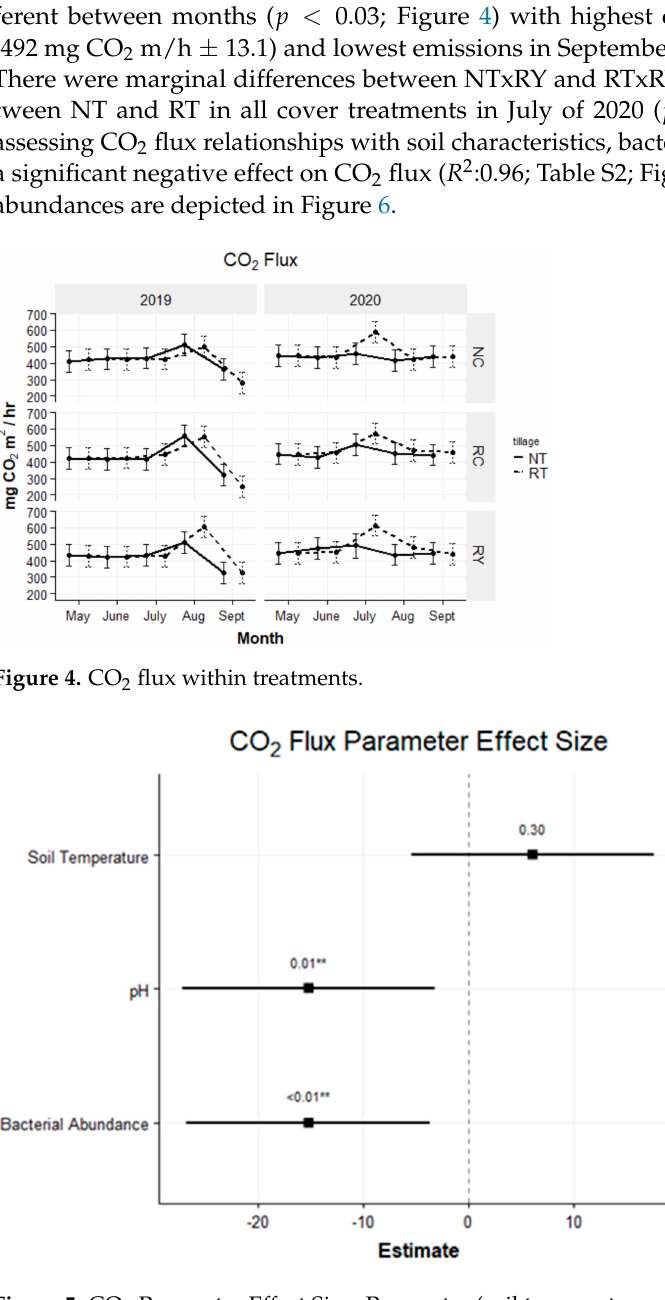
Figure 5. CO 2 Parameter Effect Size. Parameter (soil temperature, pH, bacterial abundance) effect size on carbon dioxide (CO 2 ) flux in study plots located in Stoneville, MS, USA. Solid lines denote 95% confidence intervals. p -values are reported above confidence intervals in each corresponding parameter. Double asterisk (**) denotes a significant effect.